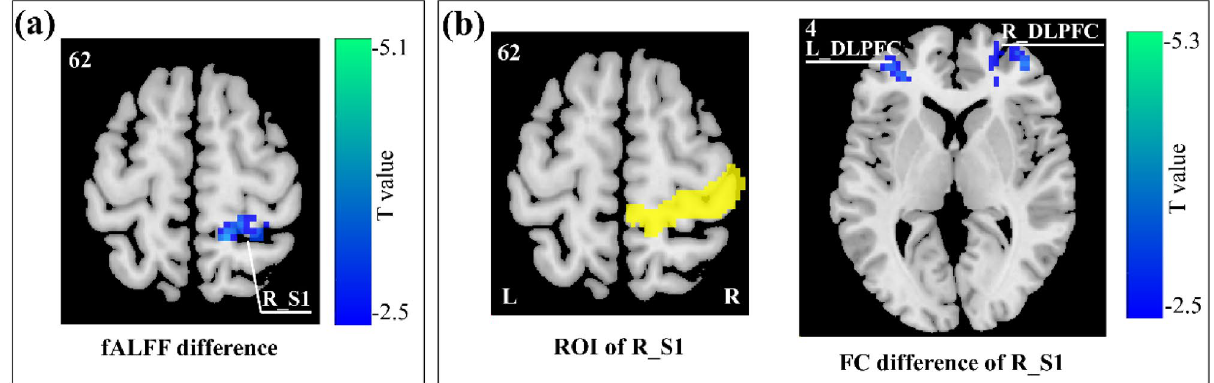
Figure 2. Differences in spontaneous brain activity and resting-state functional connectivity between the two sessions. ( a ) Decreased spontaneous brain activity (fALFF) of the right S1 was observed during T2 session as compared with T1 session. ( b ) When the right S1 was selected as the ROI, the right S1 showed decreased resting-state functional connectivity with the bilateral dorsolateral prefrontal cortex (DLPFC) during T2 session as compared with T1 session. L left hemisphere, R right hemisphere. The resulting t-statistic maps were corrected for multiple comparisons using the gaussian random field (GRF) theory with a voxel z value > 2.3 and cluster p value < 0.05 (two-tailed correction). The images were created by using the Data Processing & Analysis for (Resting-State) Brain Imaging (DPABI) software (DPABI_V5.0_201001, http://rfmri .org/dpabi ) 59